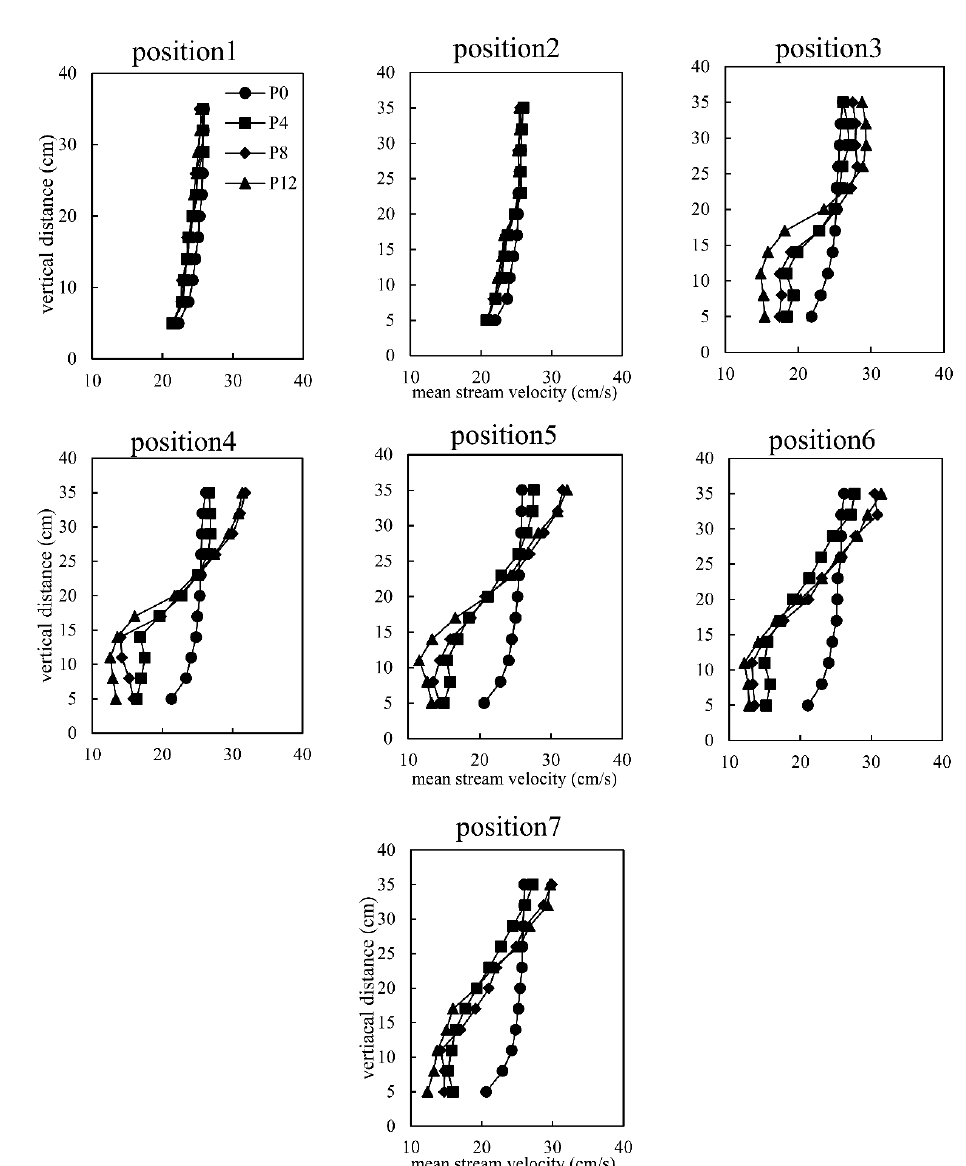
Figure 4. The mean streamwise velocity profile under different leaf numbers.